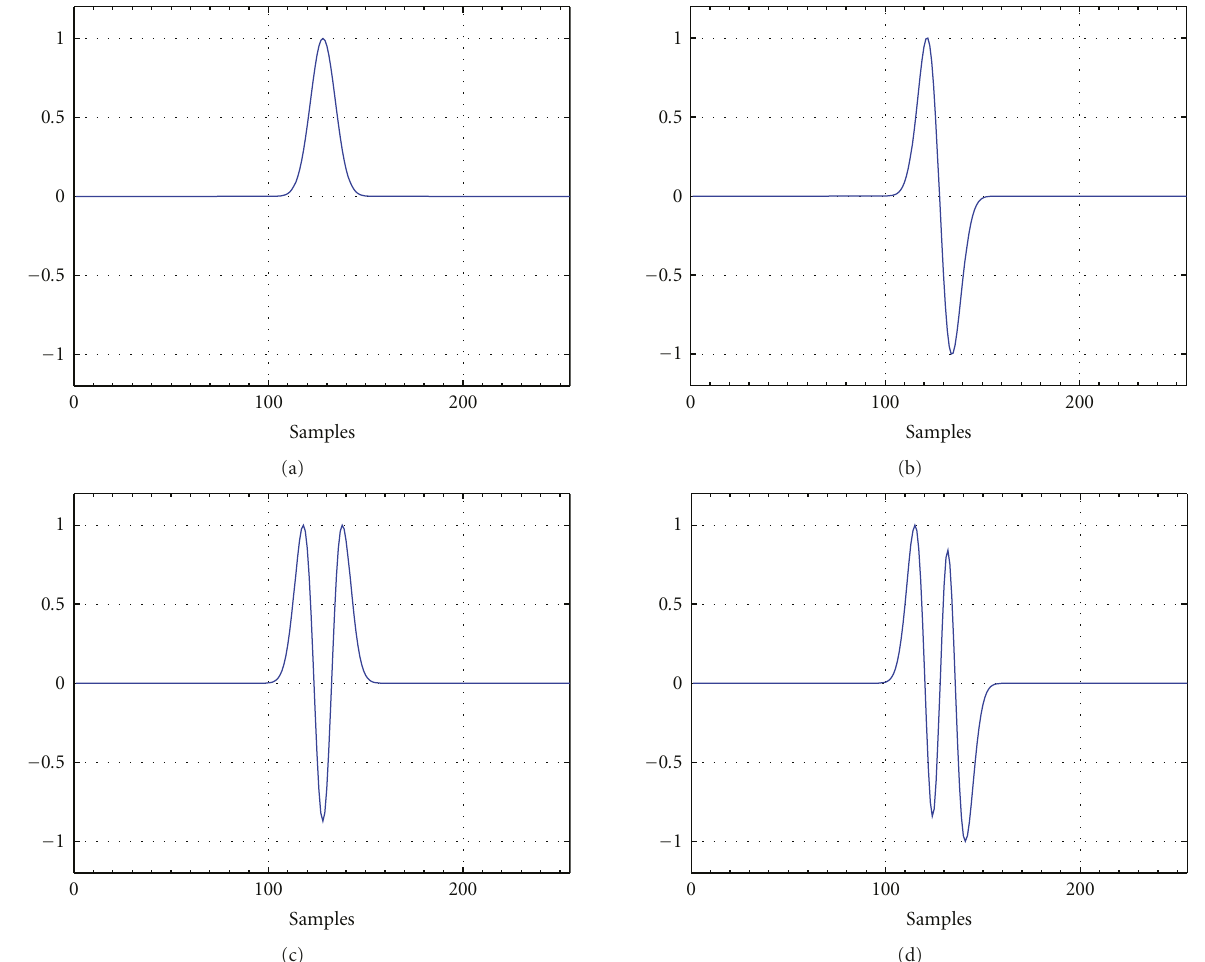
Figure 3: (a) 0th-order, (b) 1st-order, (c) 2nd-order and (d) 3rd-order Hermite-Gaussian pulses in time